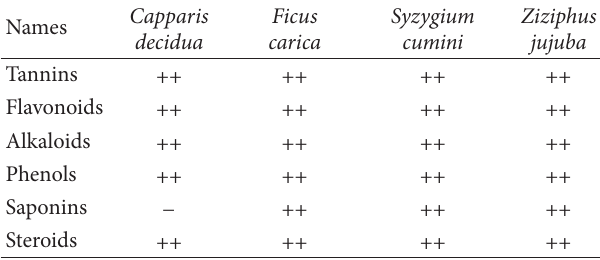
Table 2: Phytochemical screening of methanolic extract of investi- gated